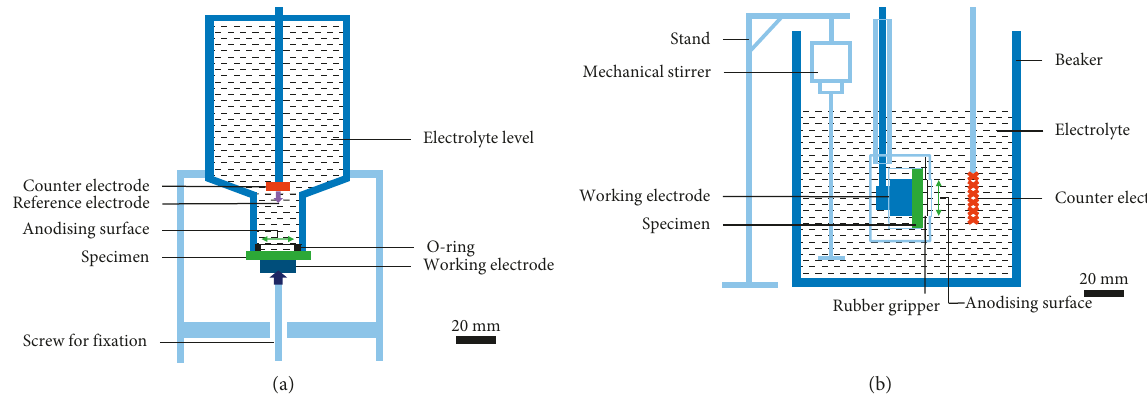
Figure 2: Typical conventional anodisation systems used in material fabrication laboratories. The number and position of electrodes involved, the configuration, and the area of anodising surface; (a) top-bottom with three-electrode configuration, reported by Molchan [34]; (b) left-right with two-electrode configuration, reported by Regonini [33, 84]. The specimen (working electrode) used in both systems is bounded by an O-ring or a rubber gripper, resulting in an anodising surface of approximately 20 mm in